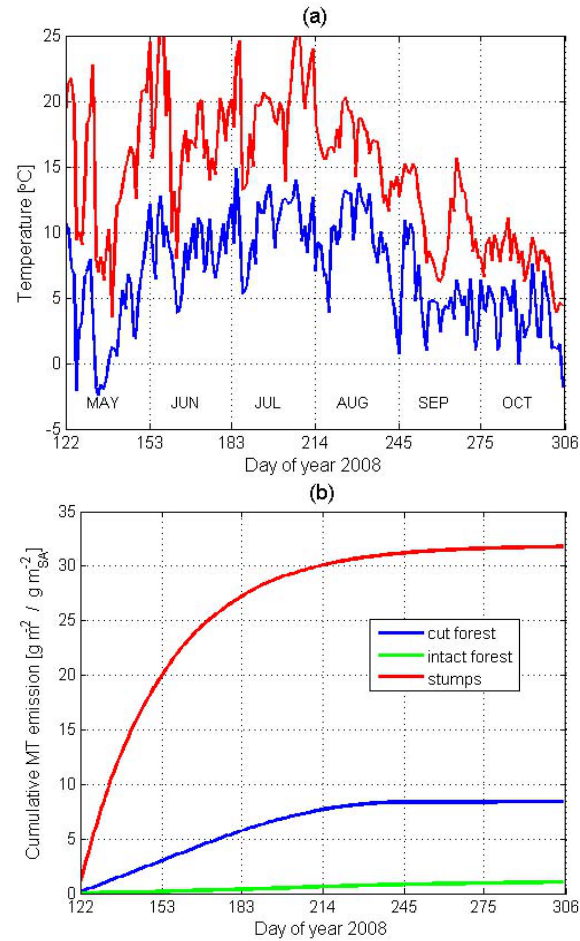
Fig. 5. (a) Daily minima (blue) and maxima (red) of the temperature data used in the upscaling. (b) Cumulative monoterpene emissions from the cut Scots pine forest (blue), intact Scots pine forest (green), and from Scots pine stumps alone (red). Note that the last one is given per stump area instead of land